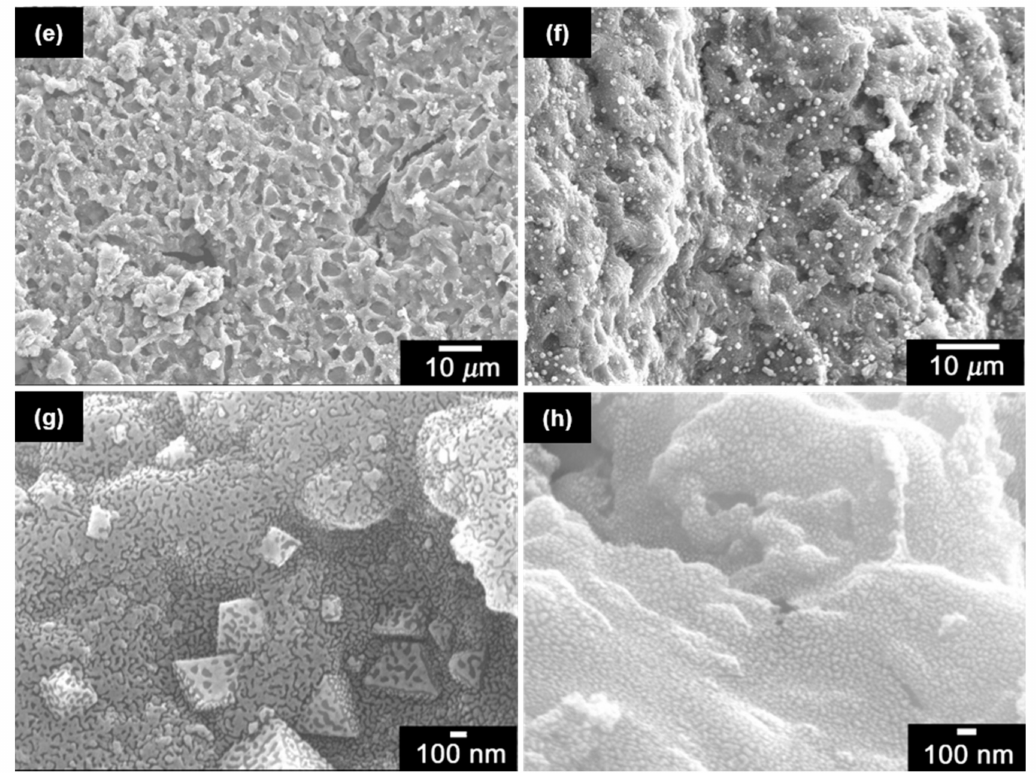
Figure 3. Scanning electron microscopy (SEM) images of B. braunii residues carbonized at 176 ◦ C ( a ); 205 ◦ C ( b ); 350 ◦ C ( c ); 550 ◦ C ( d ); 700 ◦ C ( e ); 900 ◦ C ( f ); 700 ◦ C ( g ); 700 ◦ C ( h ). ( a – g ) was carbonized under argon atmosphere; ( h ) was carbonized without argon